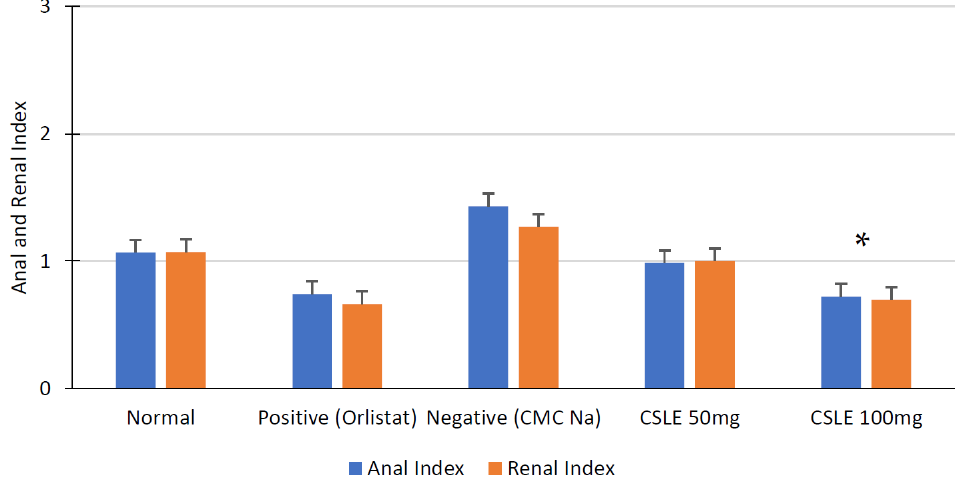
Figure 6. Carcass fat index diagram. The anal and renal fat index of CSLE dose of 100 mg/kgbw and 233